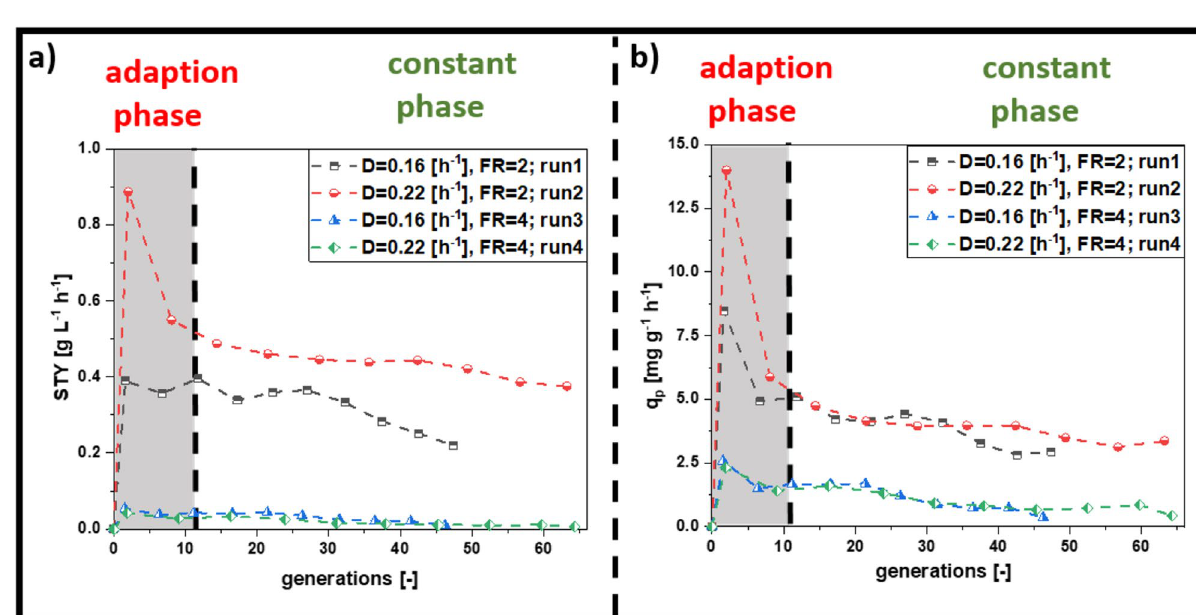
Figure 6. Results derived for cascaded continuous cultivation with mCherry, ( a ) showing the results for STY (space–time-yield) derived on a generation dependent manner, ( b ) showing q p (specific productivity) on generation based behavior; high dilution rates and moderate feeding rates seem to be beneficial for production of mCherry ( FR feed ratio, D dilution